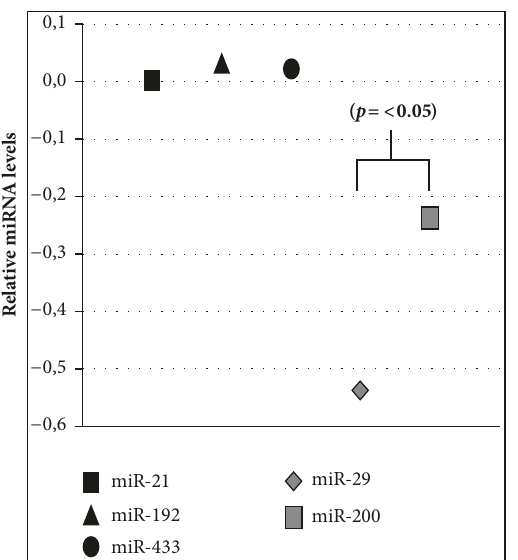
Figure 2: Relative expression levels of miRNAs in urinary sediment versus controls: Y axis represents 2 −ΔΔ Ct miRNAs values calculated by Delta-Delta Ct ( ΔΔ Ct) method versus control. Expression was normalized to U6, and data are represented as means ± SEM.